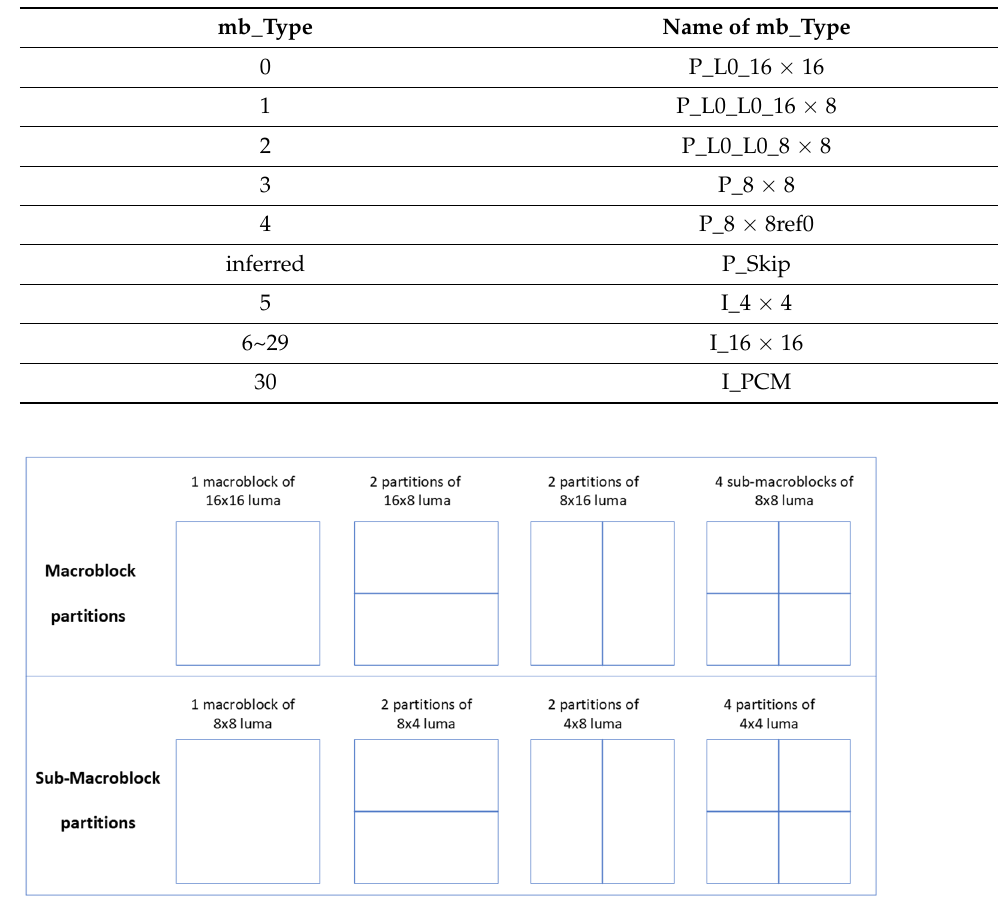
Table 3. Macroblock types for P frame.